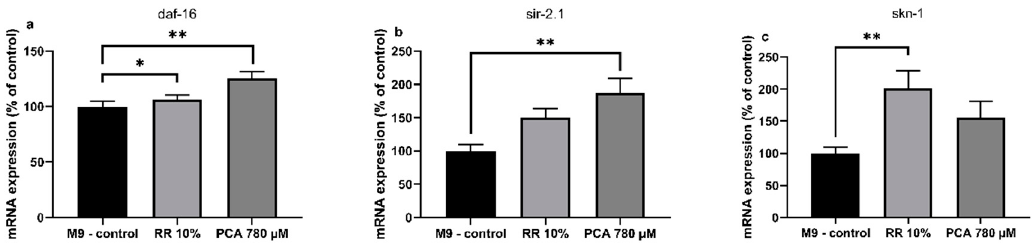
Figure 4. Relative normalized mRNA expression levels of longevity related genes ( a ) daf-16 , ( b ) sir-2.1 and ( c ) skn-1 in C. elegans after treatment with RR (10%) and PCA (780 µM); mRNA expression of M9-control is 100%; n = 10; mean ± SEM; one-way ANOVA with Tukey´s multiple comparison posttest; * p < 0.05, ** p < 0.01; results are normalized to the mRNA expression levels of amanitin resistant ( ama-1 ) and actin ( act-2 ).